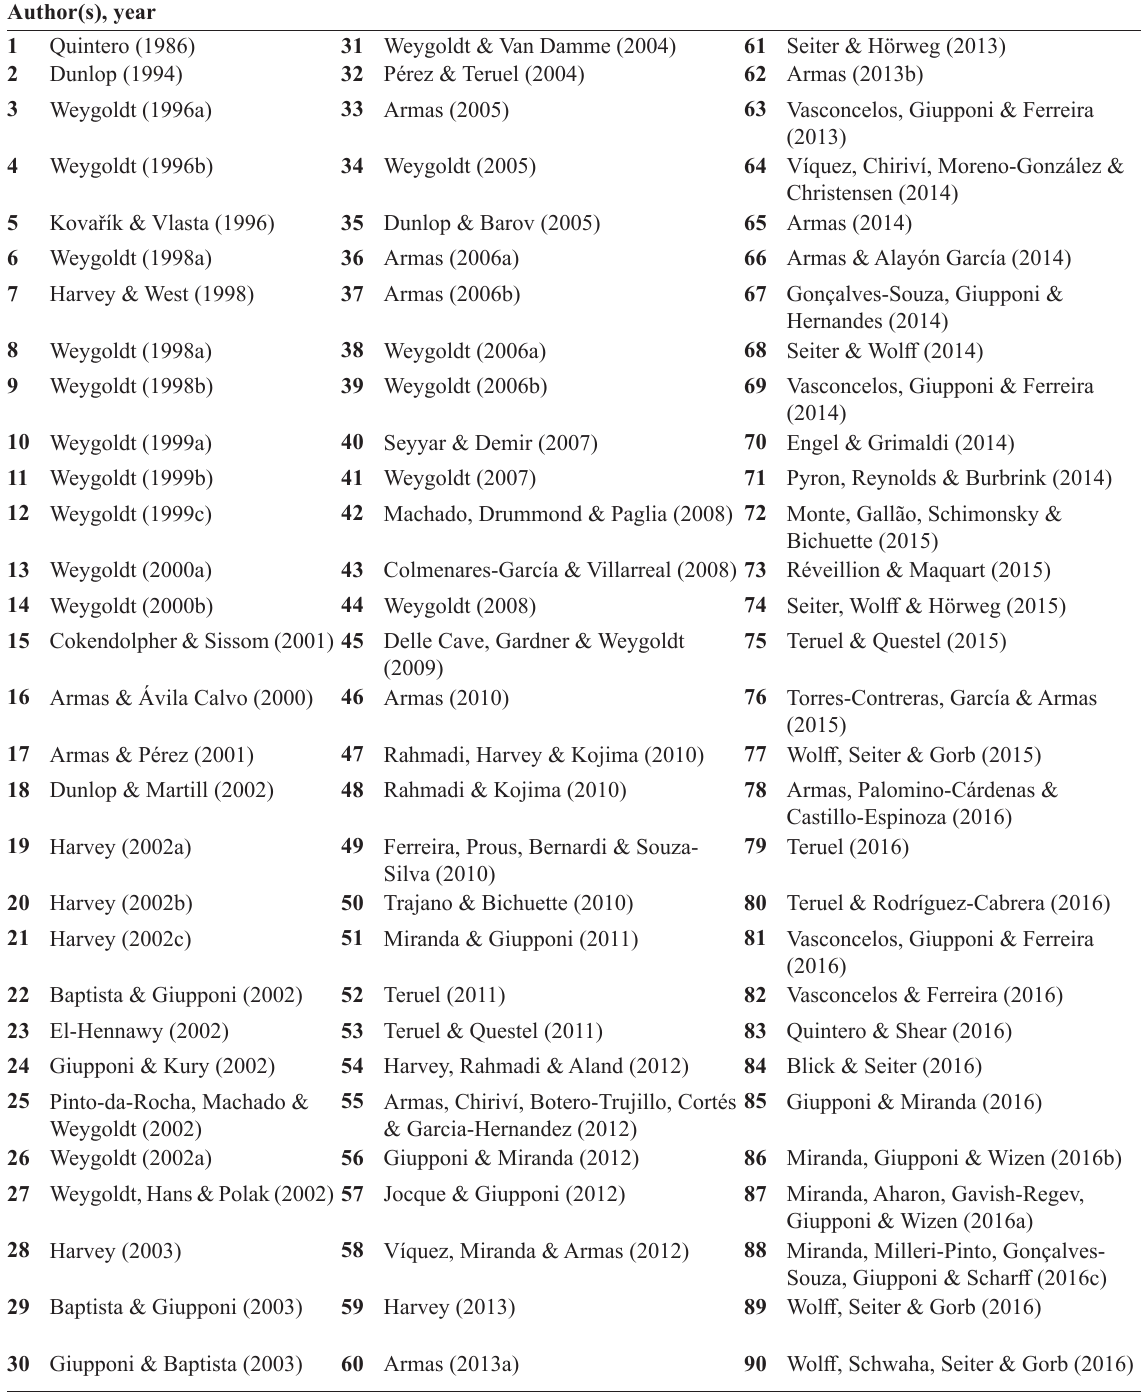
Table 1. List of published works using the name Charinidae Quintero, 1986 for whip spiders, in chronological